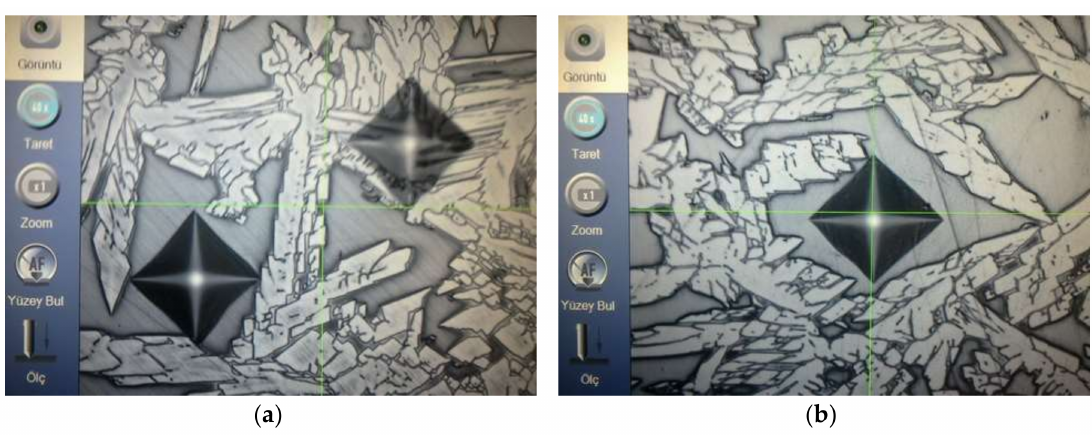
Figure 11. Microvickers hardness testing of ( a ) δ -ferrite (dark phase), austenite (light-white phase) ( b ) δ -ferrite on weld metal